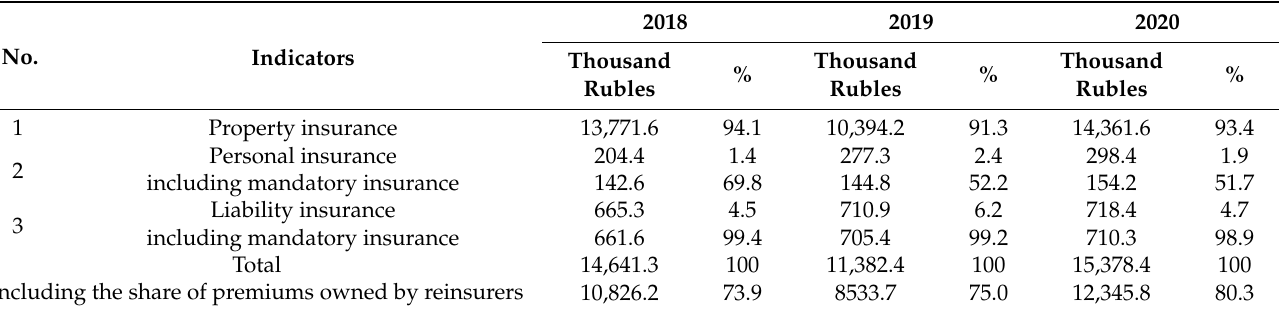
Table 1. Receipt of insurance premiums by the type of insurance in Renaissance Insurance from